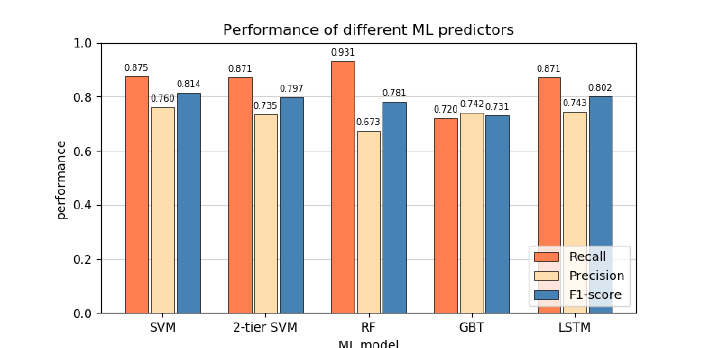
Figure 4. Recall, precision and F1-score of the different standard prediction